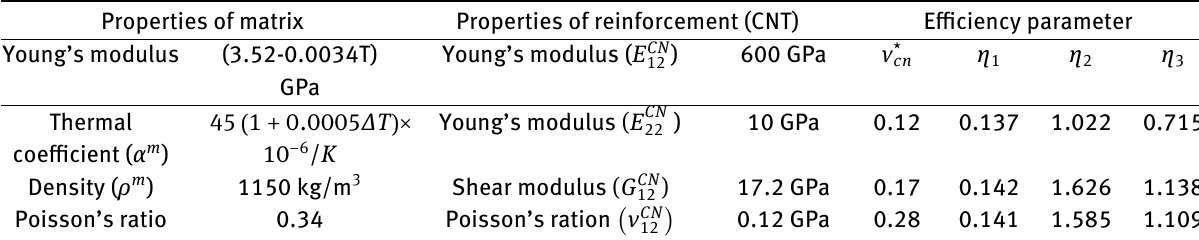
Table 1: The effective material properties of matrix (Polymethyl methacrylate) and the carbon nanotube (CNT).